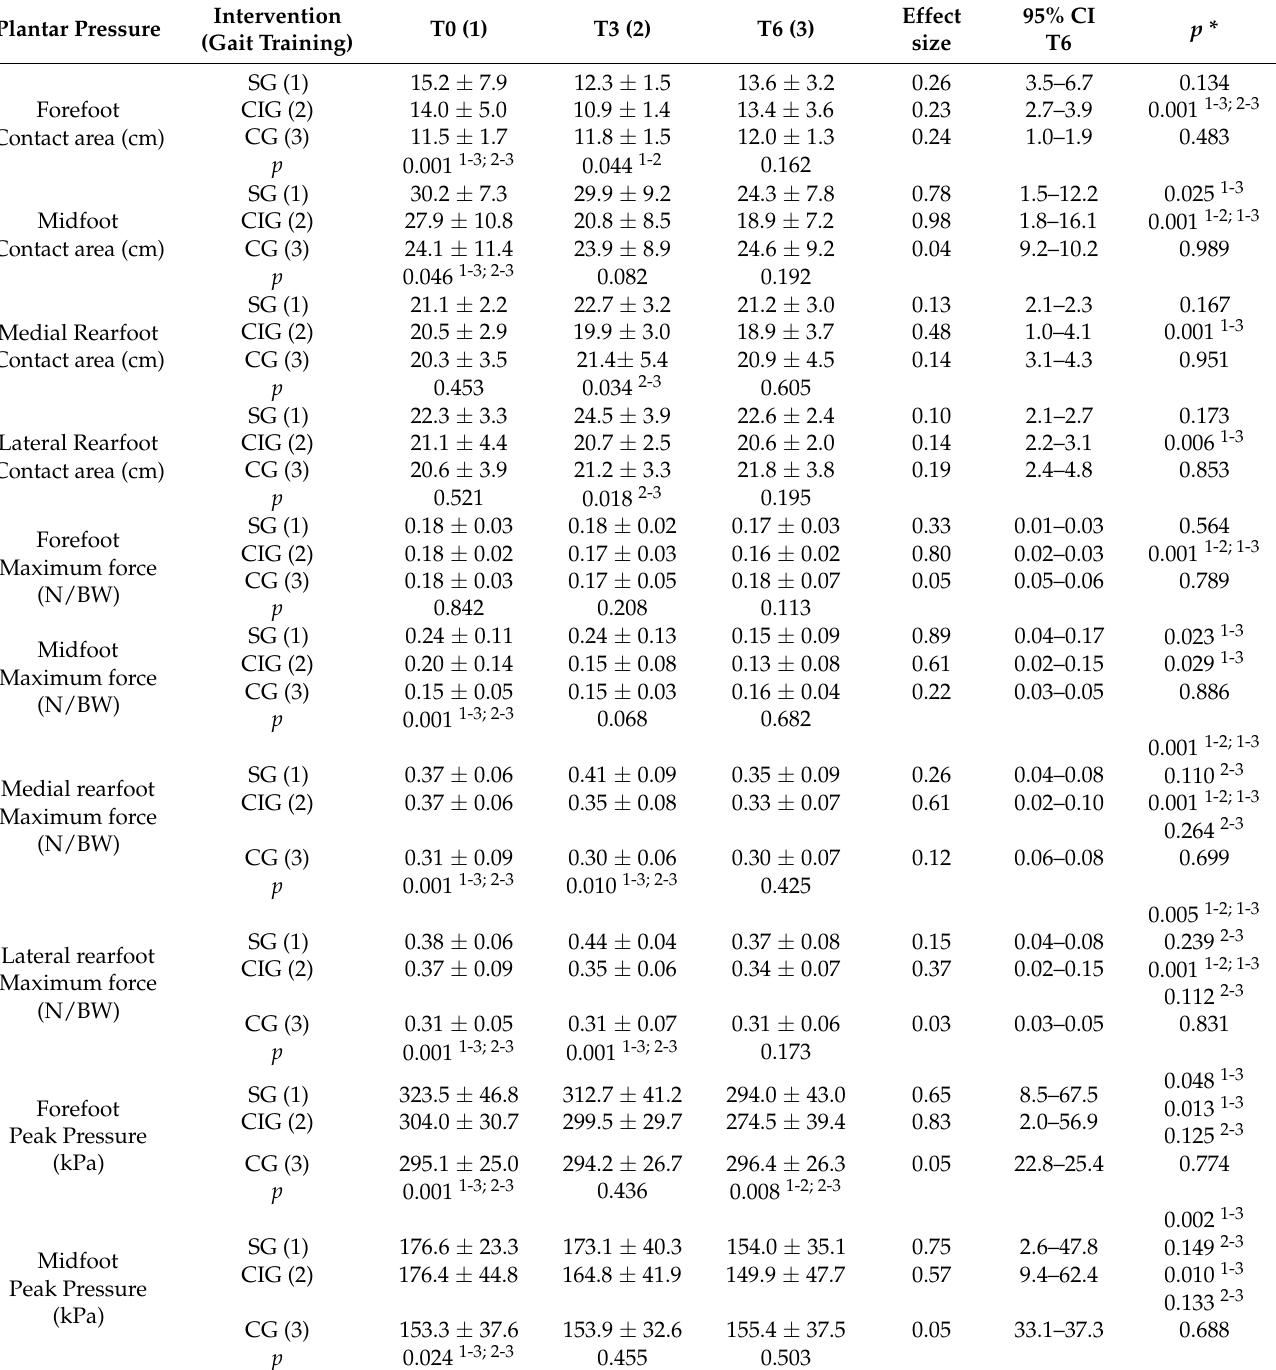
Table 5. Plantar pressure distribution in the inter-group comparisons: minimalist shoe (SG), custom insole (CIG), and control group (CG), and interventions: T0 (baseline) and after T3 and T6 months of intervention of the women with plantar fasciitis